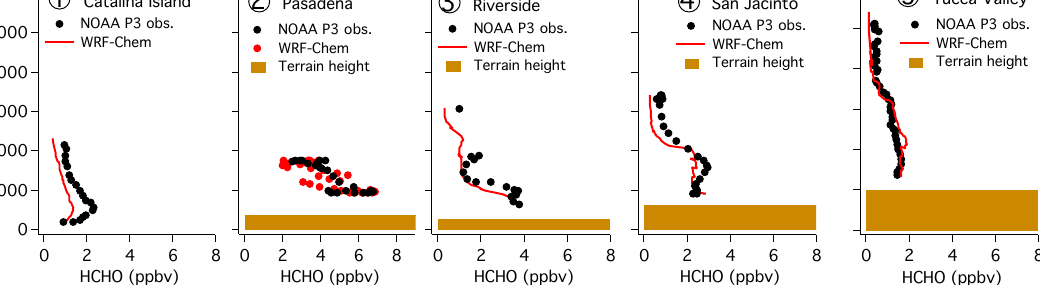
Figure 2. The flight path of NOAA WP-3 (a) and the spatial distribution of vertical profiles of aircraft observed and model simulated potential temperature (b) and HCHO (c) in the LA Basin on 4 May 2010. The black filled circles and red solid lines/symbols represent the observations and model results,